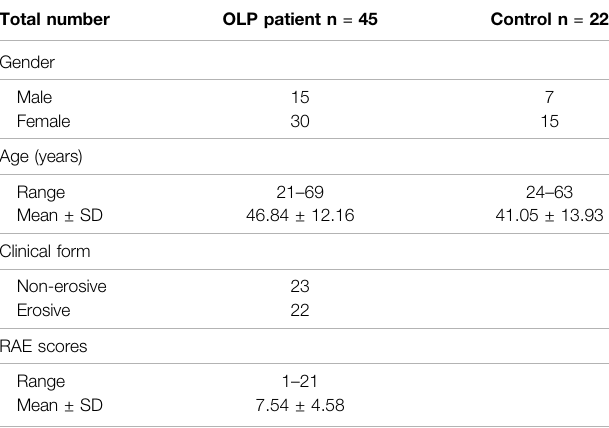
TABLE 1 | The clinical characterizations of the study